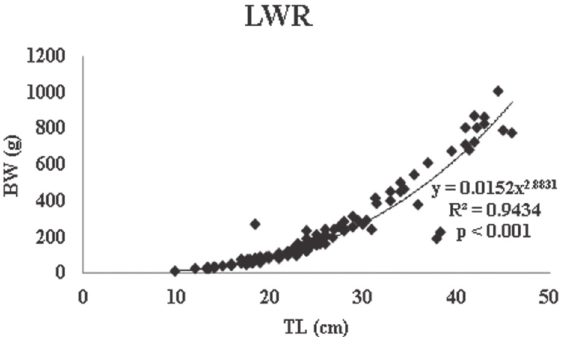
Figure 2 - Length-weight relationship of H. francisci from Itapecerica River with p <